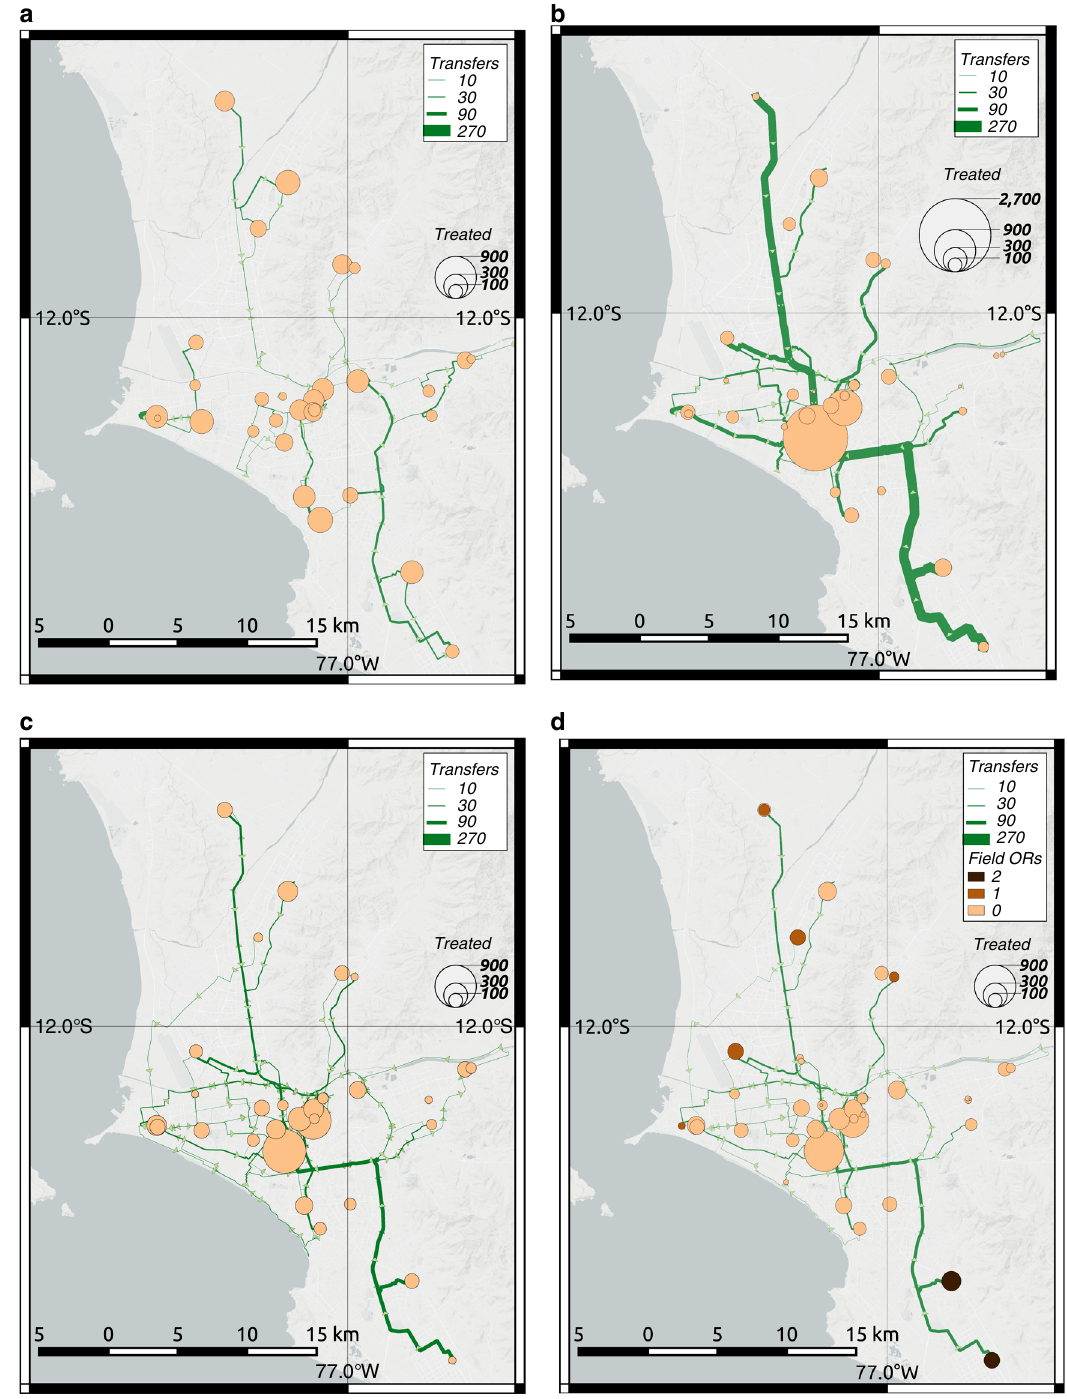
Fig. 6 Spatial distribution of average treated patients and patient transfers in the hospital system for four different emergency response plans.